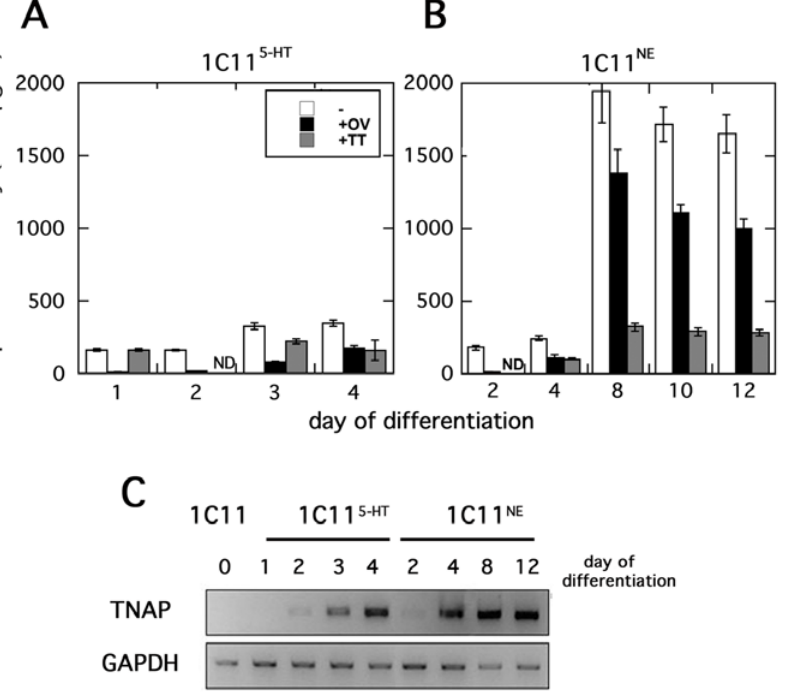
Figure 7. TNAP activity is implemented during serotonergic and noradrenergic differentiation of 1C11 cells. TNAP activity was evaluated in 1C11 5-HT (A) and 1C11 NE (B) cells during the kinetics of differentiation. The histograms represent the level of phosphatase activity (RLU/ m g prot/h) monitored without (white bars) or with orthovanadate (black bars) or tetramisol (grey bars) phosphatase inhibitors. The amount of mRNA transcripts specific of TNAP are shown in panel (C).